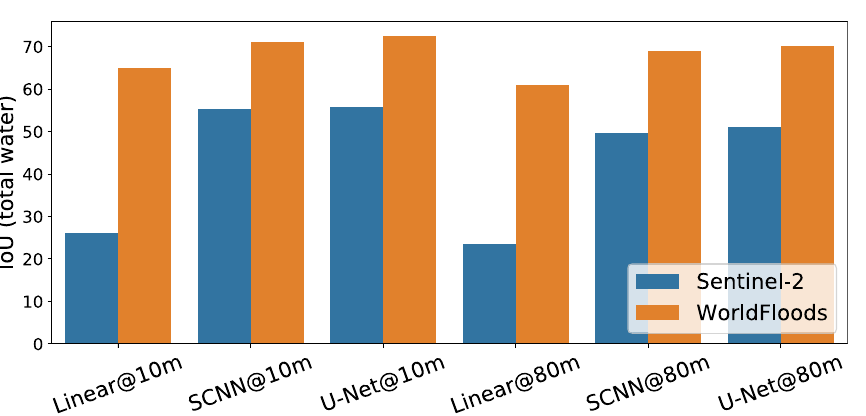
Figure 8. Performance of models trained with all WorldFloods flood maps compared with models trained only with flood maps derived from